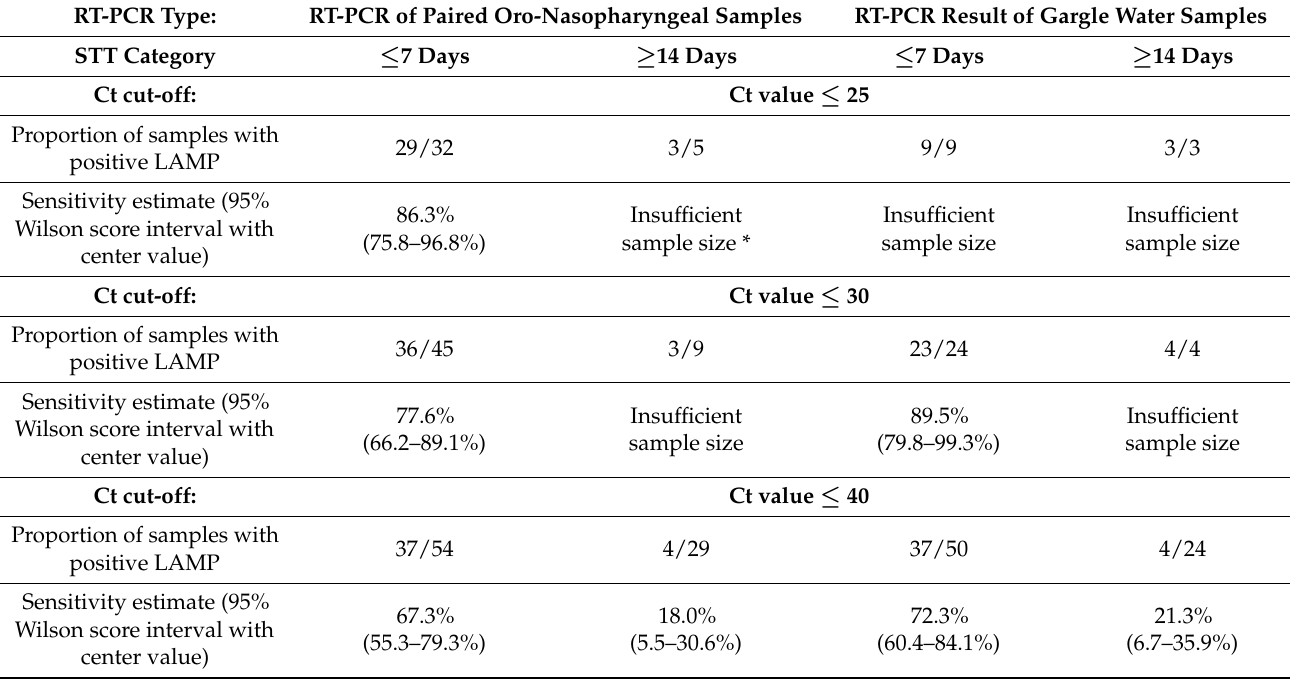
Table 3. Gargle water LAMP sensitivity with respect to indirect RT-PCR and STT